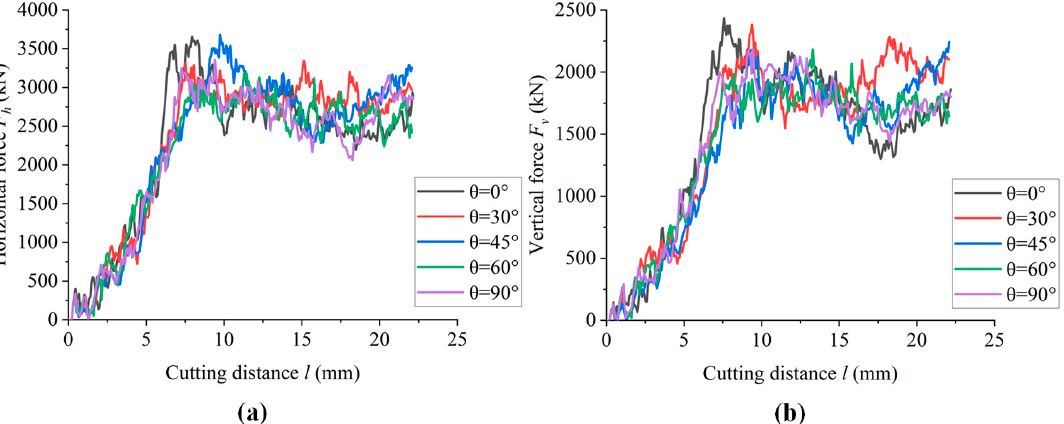
Figure 7. Cutting force vs. cutting distance curves of different bedding dips. ( a ) Horizontal compo- nent vs. cutting distance; ( b ) vertical component vs. cutting distance.